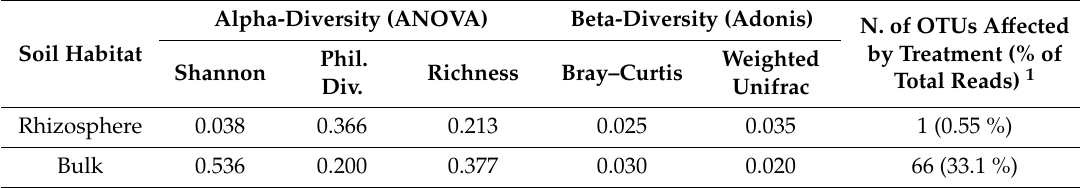
Table 2. Significance p values of alpha- and beta-diversity metrics for the factor “fertilization treatment”, calculated on individual soil habitats, and number of OTUs significantly a ff ected by the same factor in each individual soil habitat. Significant values ( p < 0.05) are highlighted in bold. Phil. Div. = phylogenetic